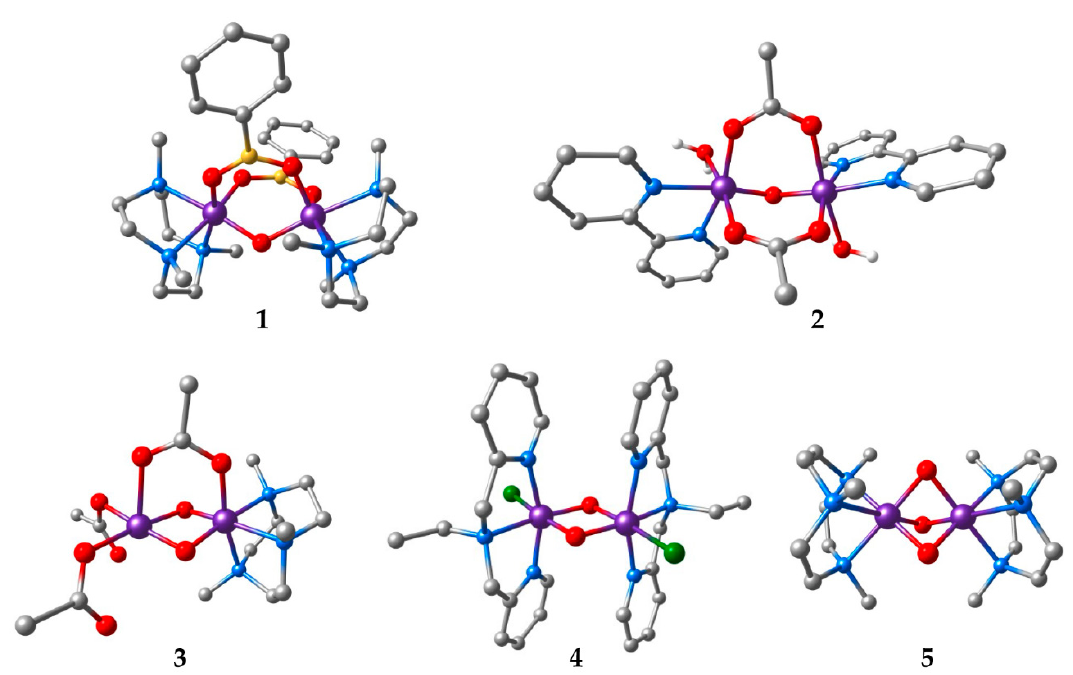
Figure 1. Structures of the manganese complexes included in this study. Hydrogen atoms bound to carbons are omitted for clarity (Mn: purple; C: grey; N: blue; O: red; B: yellow; Cl: green).